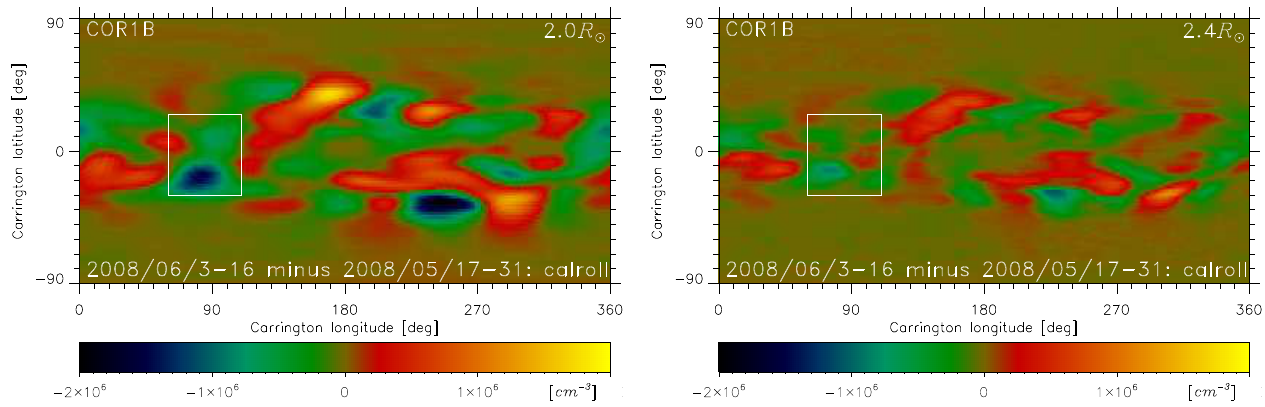
Fig. 3. Difference in reconstructed electron density for the periods after the CME of 1 June 2008 (CME1) and before. The spherical cross-sections are shown at heliocentric distances 2 . 0 and 2 . 4 R ⊙ (the distances are shown in the right upper corners).